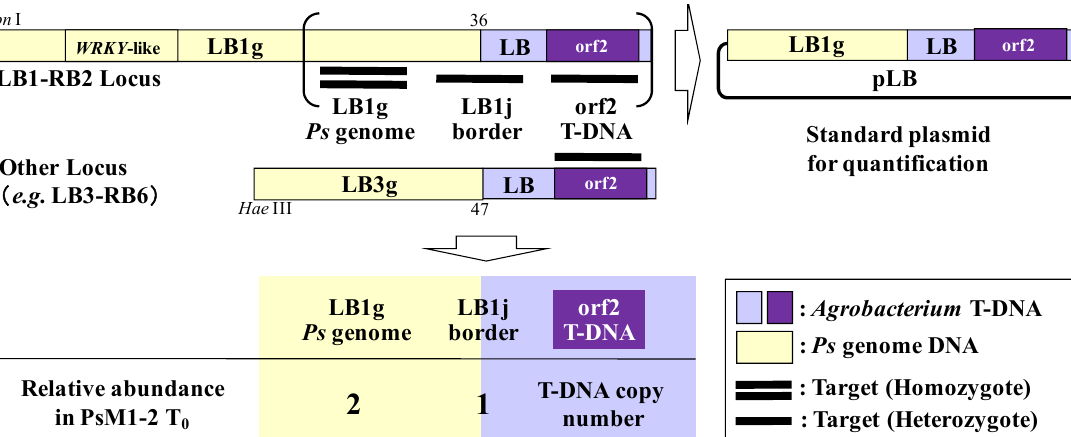
DNA: Agrobacterium : Ps genome